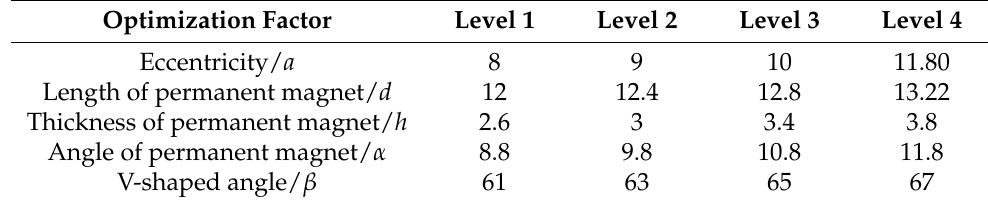
Table 6. Number of levels for the optimization